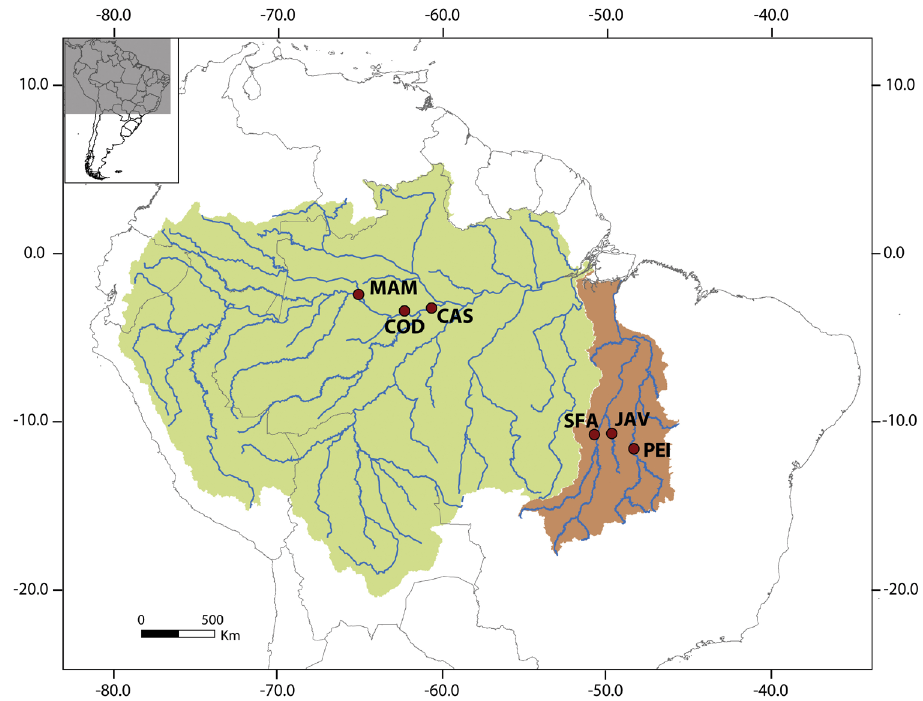
FIGURE 1 | Map of northern part of South America showing the sampling sites of Arapaima individuals analyzed in this study from Araguaia-Tocantins (brown) and Amazon (green) River basins, coded in the Tab.